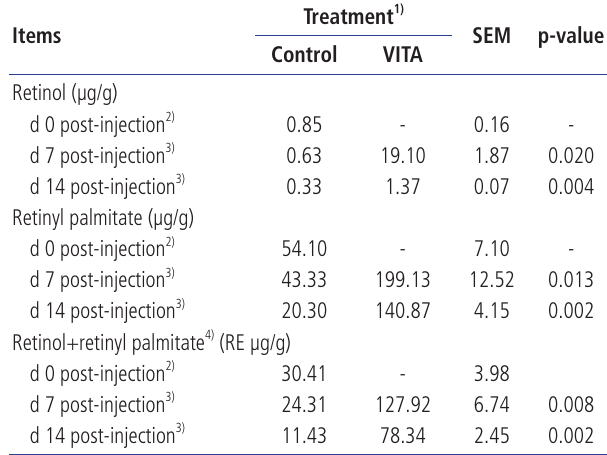
concentrations in Table 4. Retinol and retinyl palmitate concentrations in liver of pigs 3 administered with fat-soluble vitamins Items